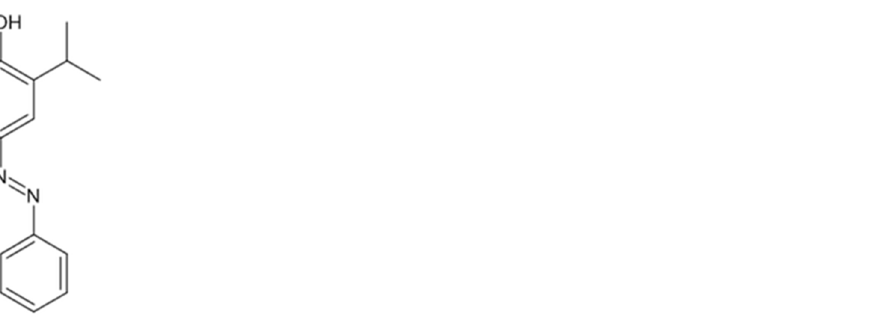
Figure 10. Chemical structure of the product of propofol derivatization using azo-coupling reac- tion.